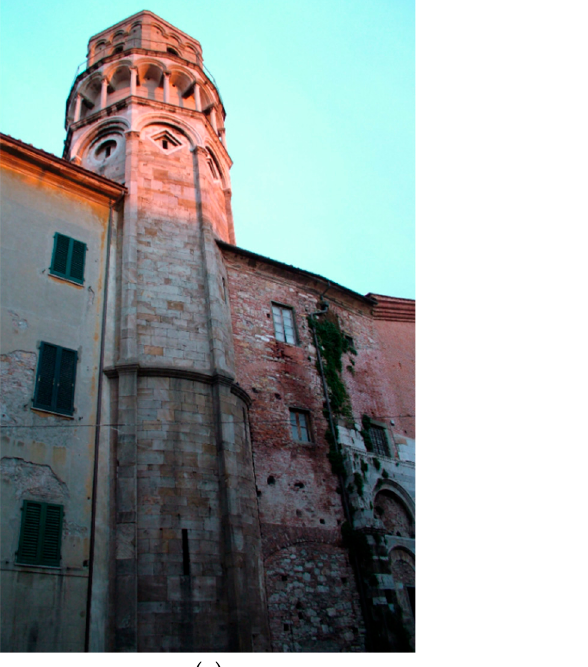
Figure 12. The bell tower of the St. Nicola Church in Pisa: ( a ) the bell tower from St. Maria Street; ( b ) the belfry.